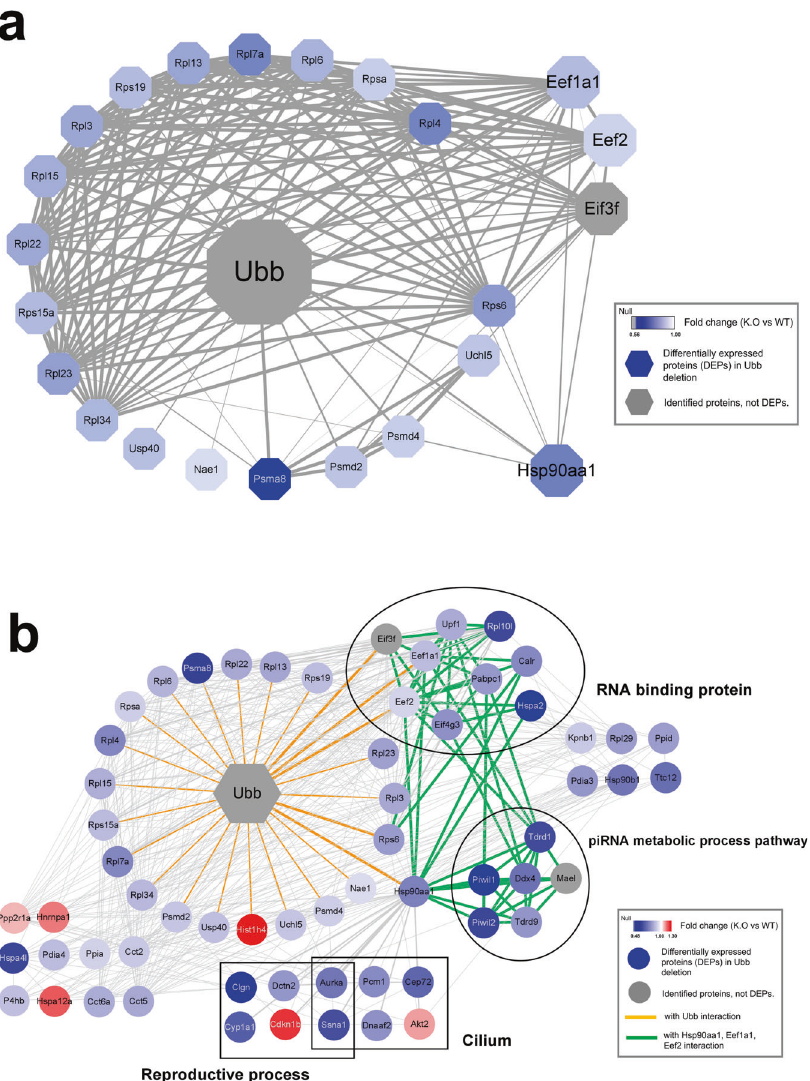
Fig. 3 Network of proteins affected by Ubb . a Interaction between Ubb and signi fi cantly downregulated proteins because of the disruption of Ubb . In the interaction map, the thickness of the edge is proportional to the combined score. All interactions contribute to the combined score; higher scores correlate to more biologically meaningful evidence. The node color scale indicates the fold-change values, and nodes for proteins without signi fi cant differential expression are indicated with gray. b A network of Hsp90aa1, Eef1a1, and Eef2 proteins affected by the presence of Ubb and proteins related to fertility. The orange edges are the interaction between Ubb and the fi rst shell, while green edges refer to the interacting partners of Hsp90aa1, Eef1, and Eif4g3. The proteins involved in RNA binding, piRNA metabolic process, cilia, and reproductive process are indicated with black circles and squares. This network has been created with STRING in